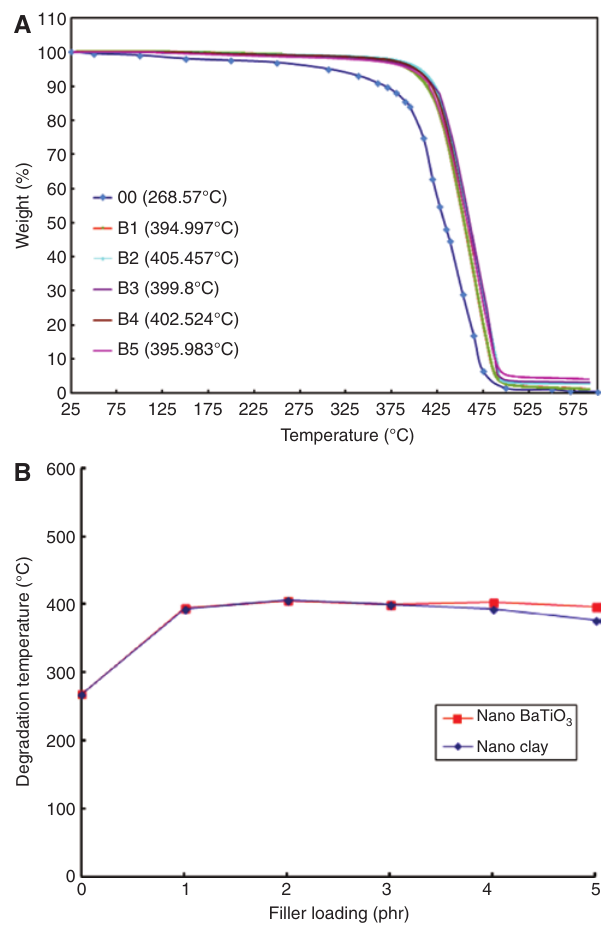
Figure 1: (A) TGA curve and (B) degradation temperature as a func- tion of filler loading of photopolymer/BaTiO